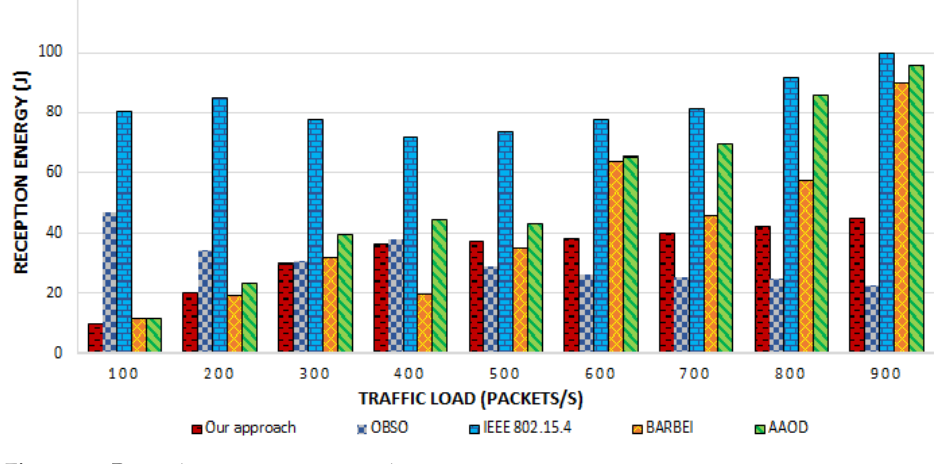
Figure 11. Reception energy consumption.